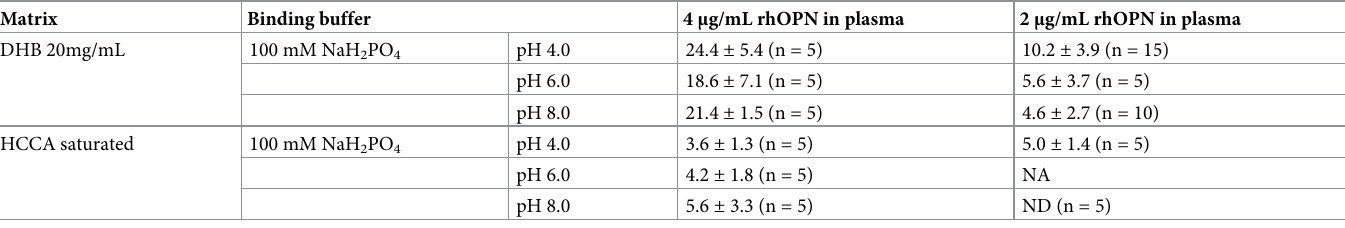
NA–Not analyzed. ND–Not detected. For the data having S/N < 3, 3 was used for calculation (Raw data are shown in S4